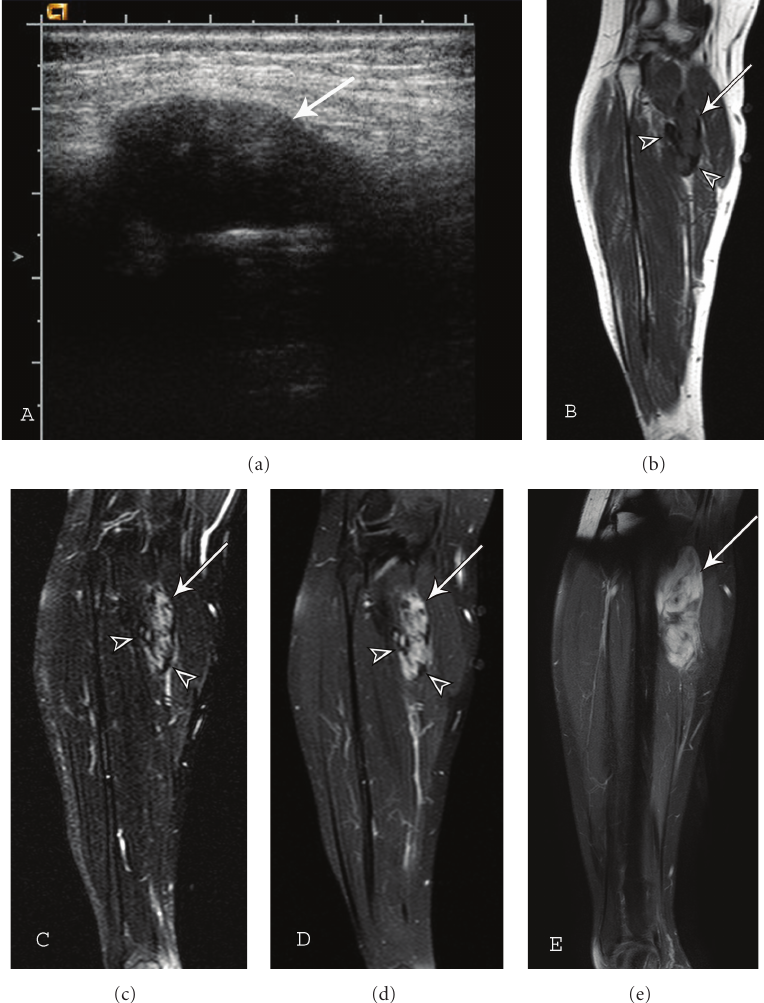
Figure 3: Extraabdominal fibromatosis of the popliteus and soleus muscles after pregnancy: a 27-year-old female with growth of a calf desmoid tumor noted during and after pregnancy. (a) Transverse sonography of the lesion (arrow) during a needle biopsy demonstrates a well-defined, heterogeneous hypoechoic mass. (b) T1-weighted (TR450/TE24) image reveals a heterogeneous lesion (arrow) measuring 6.6 centimeters (cm) × 2.9 cm in the coronal plane with signal similar to skeletal muscle. (c) Coronal T2- (TR3000/TE90) and (d) T1-weighted (TR450/TE24) postcontrast sequences with fat suppression shows a heterogeneous lesion (arrow) with central enhancement and significant band-like low signal component (arrowheads) predominantly at the periphery. (e) Coronal T1-weighted (TR484.913/TE7) postcontrast with fat saturation was obtained one year and nine months following the other MR images ((b)–(d)) and five months after partum. Both the size (9.8cm × 3.3cm in the coronal plane) of the desmoid tumor (arrow) and relative proportion of enhancing cellular tissue have increased under hormonal